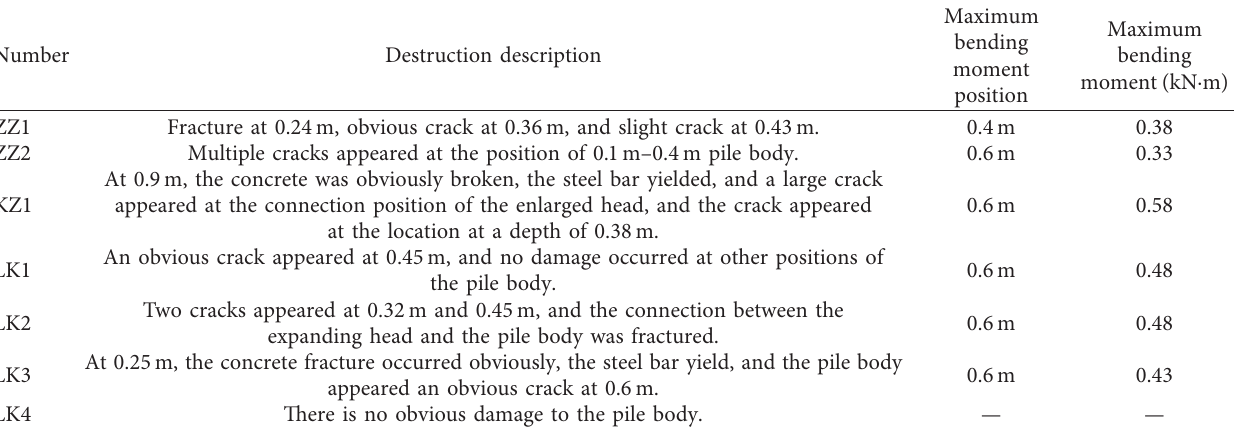
Table 4: Failure statistics of three pile types.